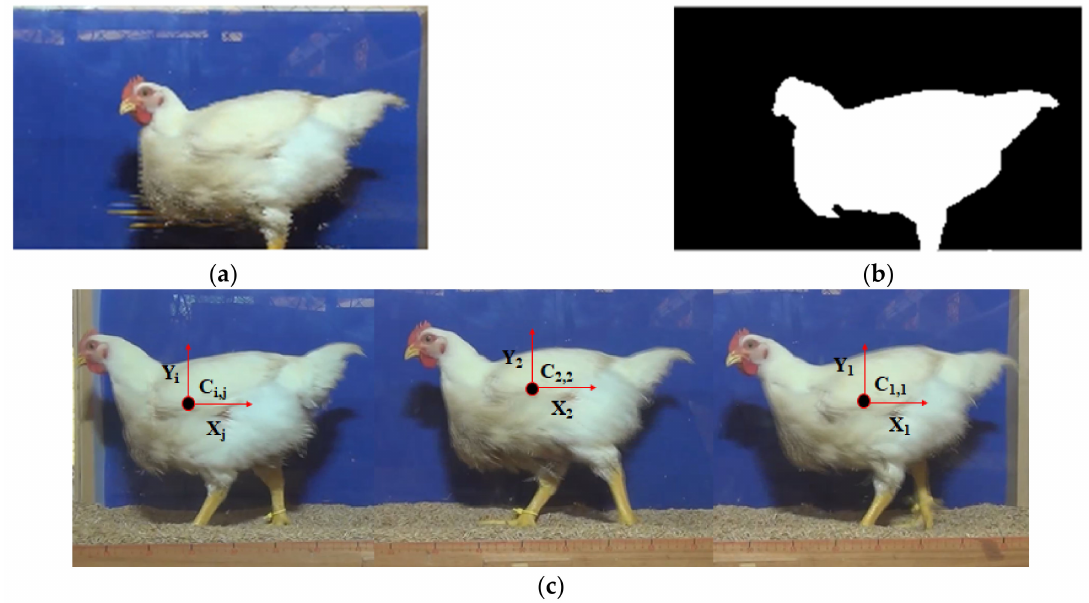
Figure 2. Original ( a ) and segmented ( b ) images of the broiler walking the defined path to assess the gait score and the displacement of the center of mass ( c ). C i,j is the center of mass in the frame